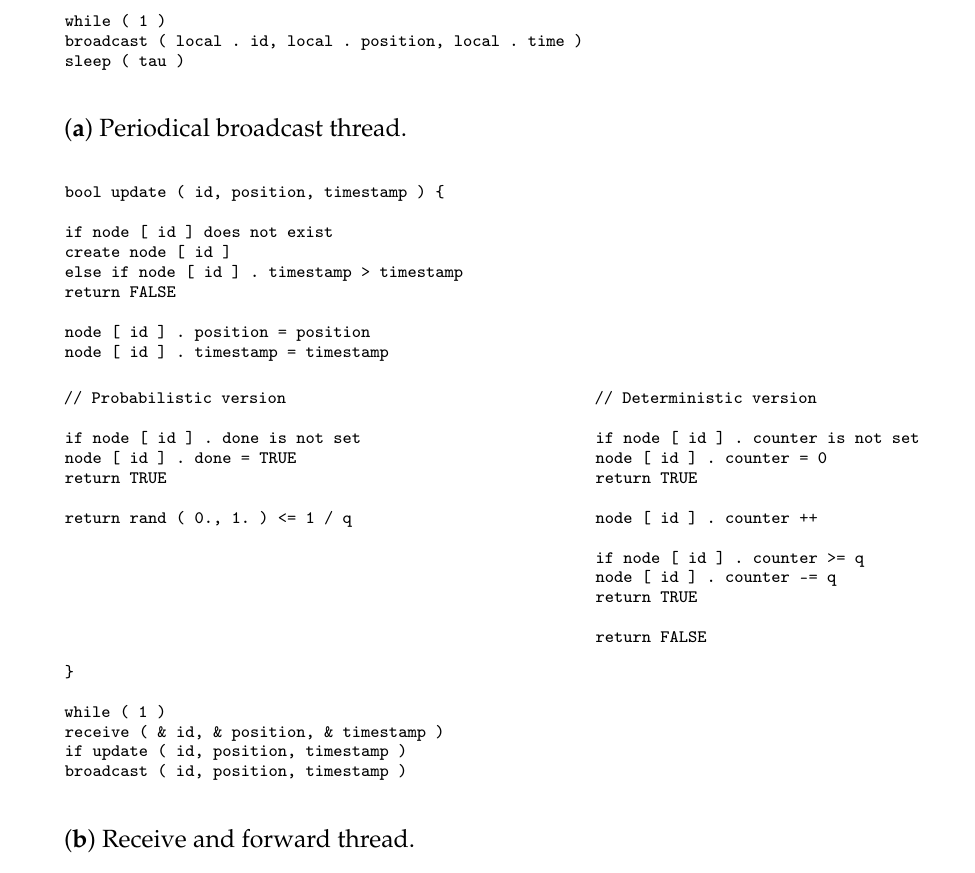
Figure 3. Semiflooding-location-service (SFLS)